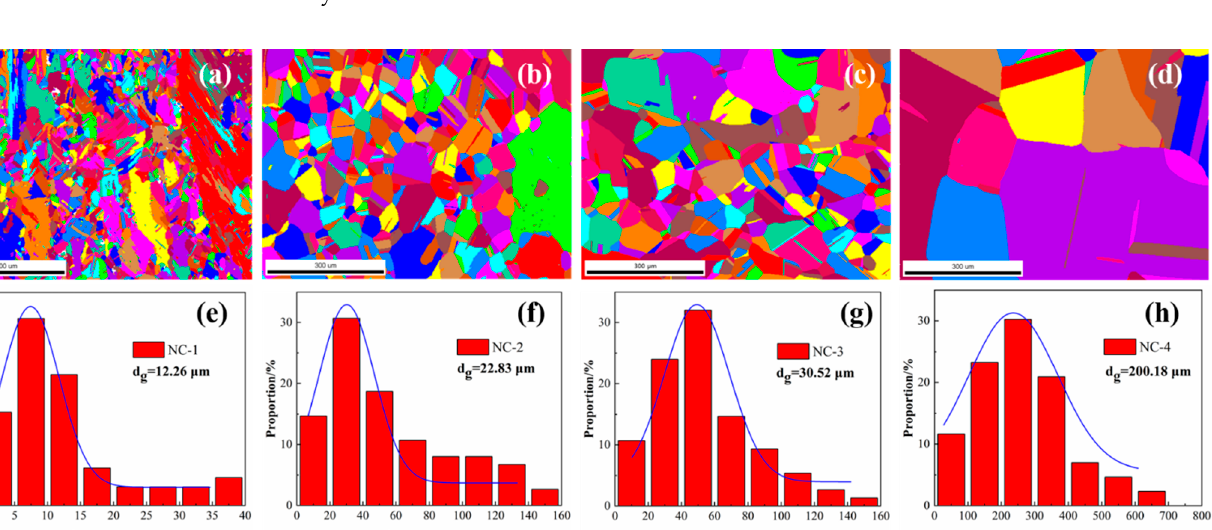
Figure 2. Comparison of mechanical properties of the tested alloys at the peak aging state.